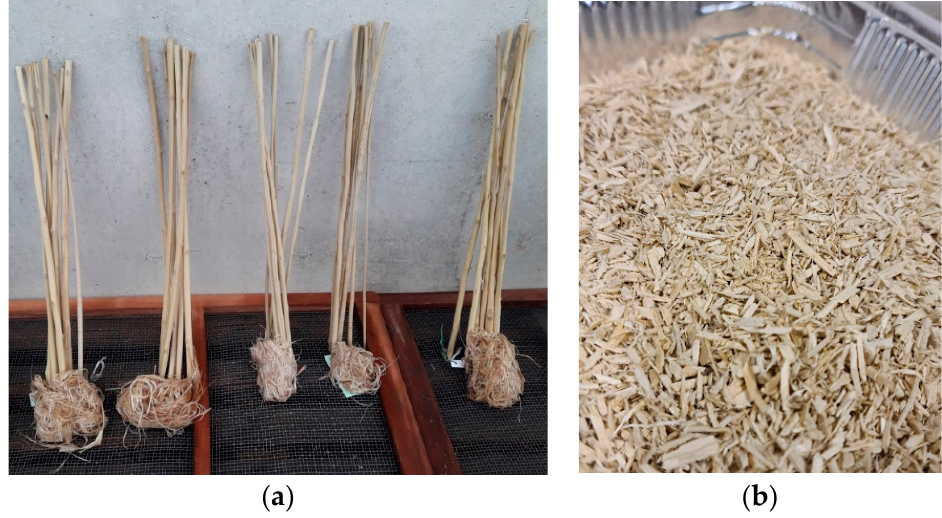
Figure 1. Hemp sample treatments, ( a ) fiber removal; ( b ) hemp shives.